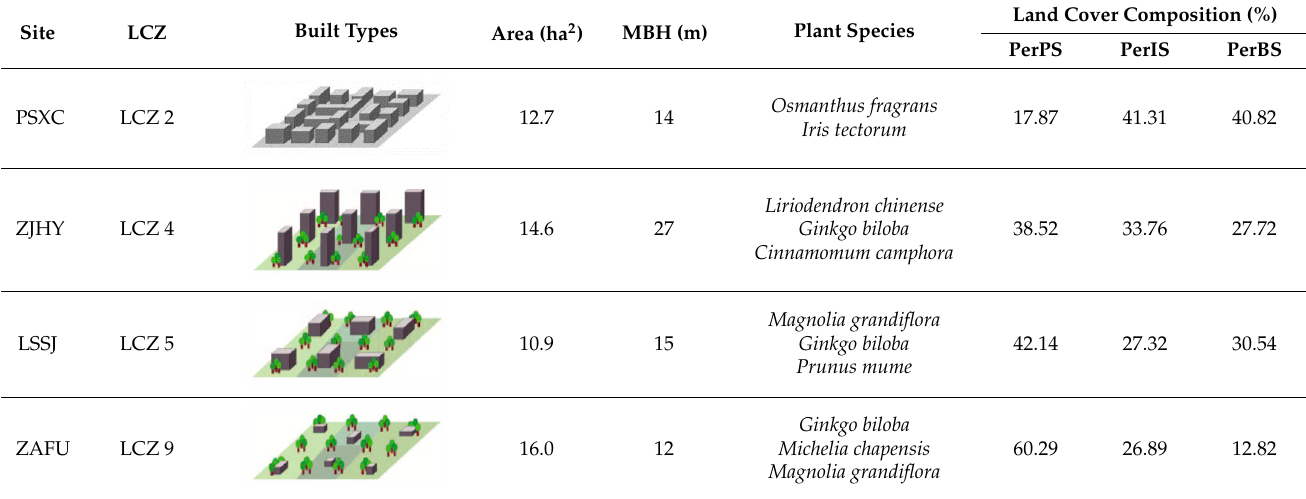
Table 1. Landscape parameters of each study site.